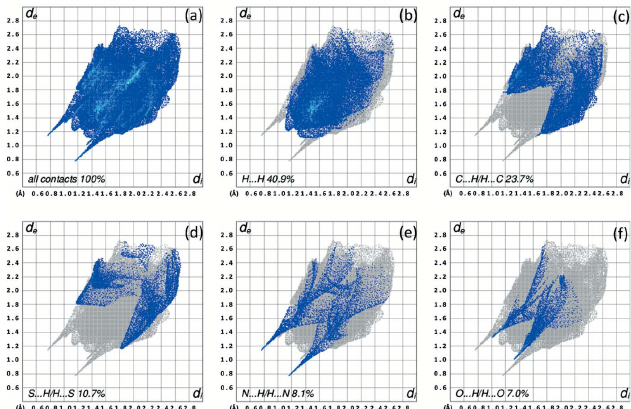
Figure 7 Two-dimensional fingerprint plots for the title compound, ( a ) for all contacts and delineated into ( b ) H (cid:3)(cid:3)(cid:3) H, ( c ) C (cid:3)(cid:3)(cid:3) H/H (cid:3)(cid:3)(cid:3) C, ( d ) S (cid:3)(cid:3)(cid:3) H/ H (cid:3)(cid:3)(cid:3) S, ( e ) N (cid:3)(cid:3)(cid:3) H/H (cid:3)(cid:3)(cid:3) N and ( f ) O (cid:3)(cid:3)(cid:3) H/H (cid:3)(cid:3)(cid:3) O contacts. d i and d e denote the closest internal and external distances (in A˚ ) from a point on the